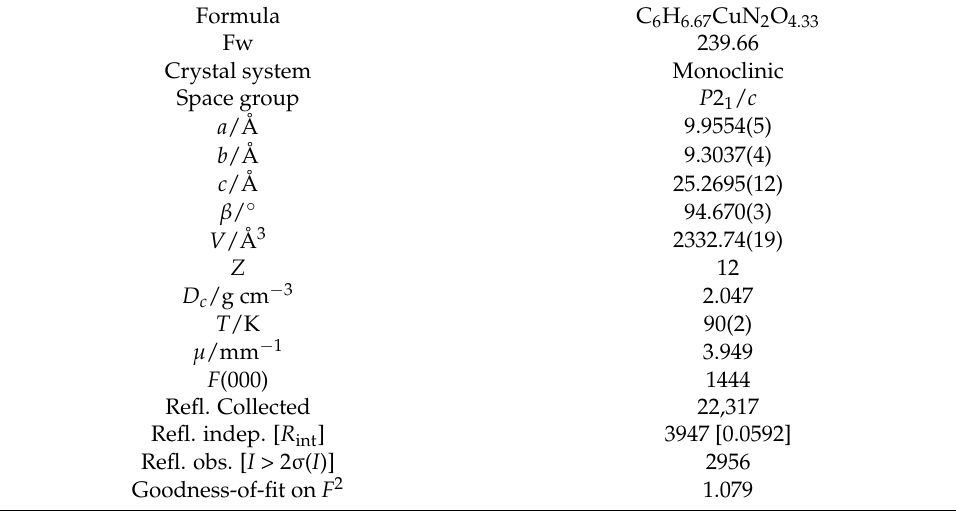
Table 1. Summary of crystal data and structure refinement for